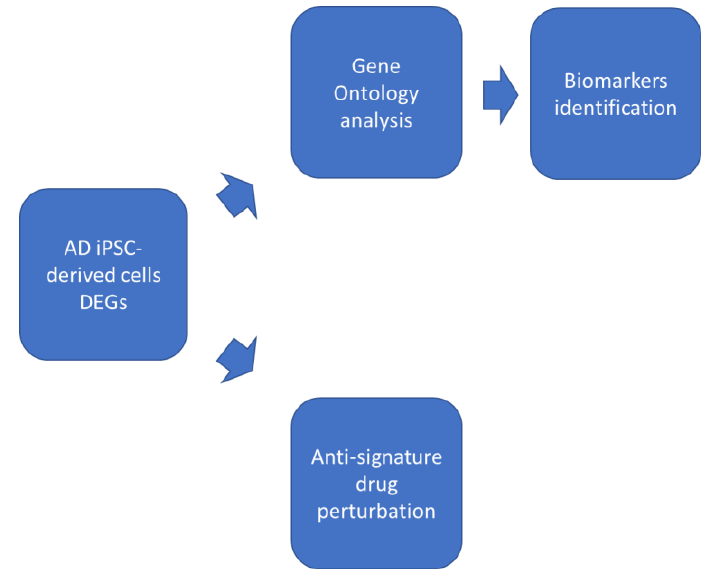
Figure 1. Study plan.